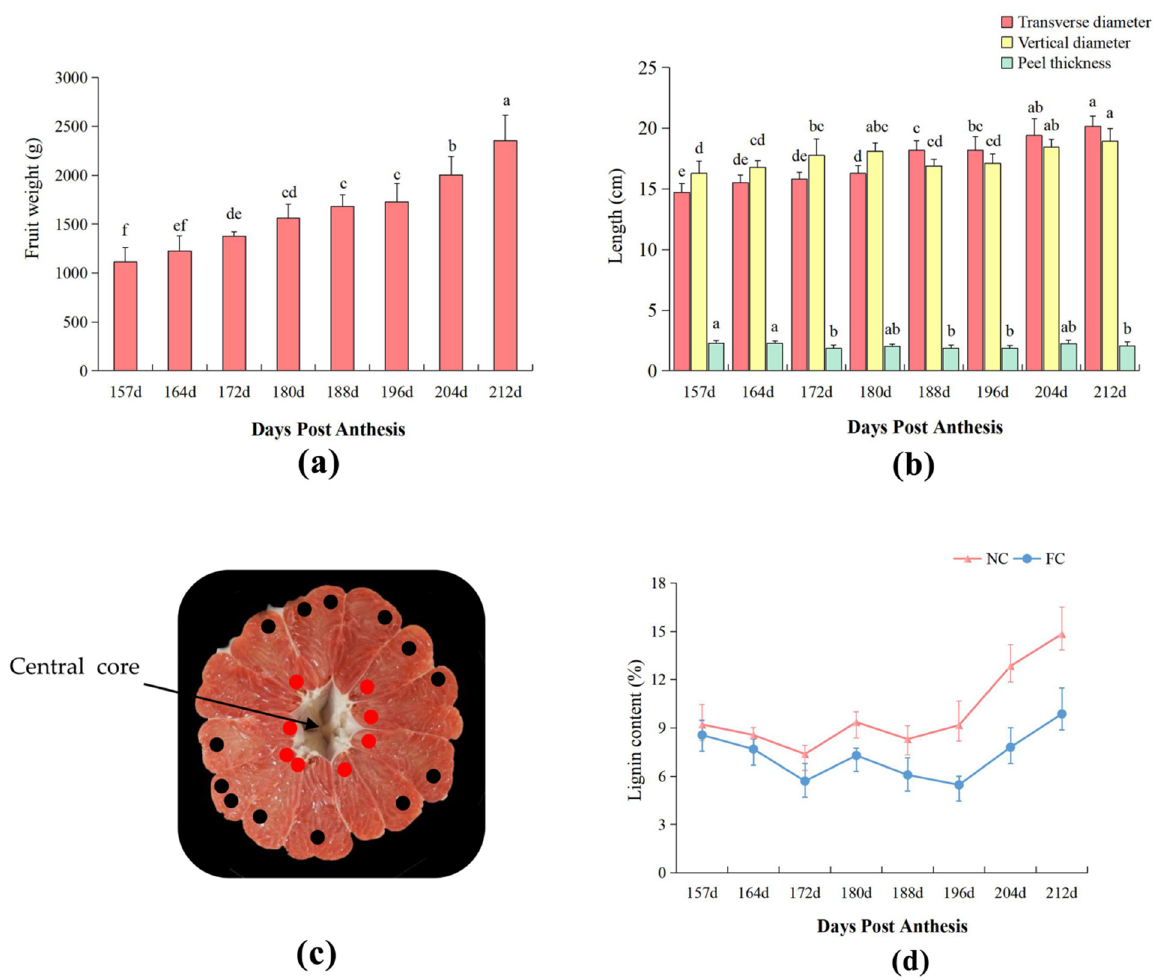
Figure 2. The dynamic changes in physiological indicators of ‘SH’ at different developmental stages. ( a ) Changes in fruit weight from 157–212 d; ( b ) Changes in the transverse diameter, vertical diameter, and peel thickness at different developmental stages; ( c ) Morphological diagram of a fruit cross- section, where the red dots indicate the juice sacs near the core (NC), and the black dots indicate the juice sacs far away from the core (FC); ( d ) The lignin content of fruit juice sacs in NC and FC at different development stages. Each data point is the average of three biological repeats, and different letters indicate significant differences at p < 0.05 as determined by a one-way analysis of variance (ANOVA) with Duncan’s multiple range test and Kruskal–Wallis test.